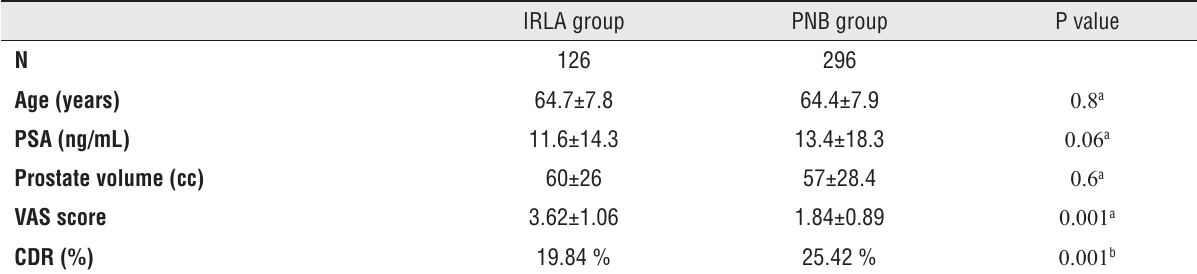
Table 1 - Data of the patient characteristics, vAs score and cDR in IRLA and pnB groups.